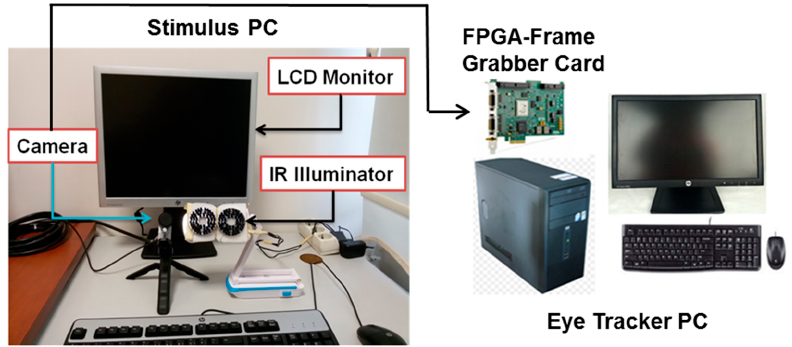
Figure 1. Proposed eye gaze tracking system. IR: infrared.